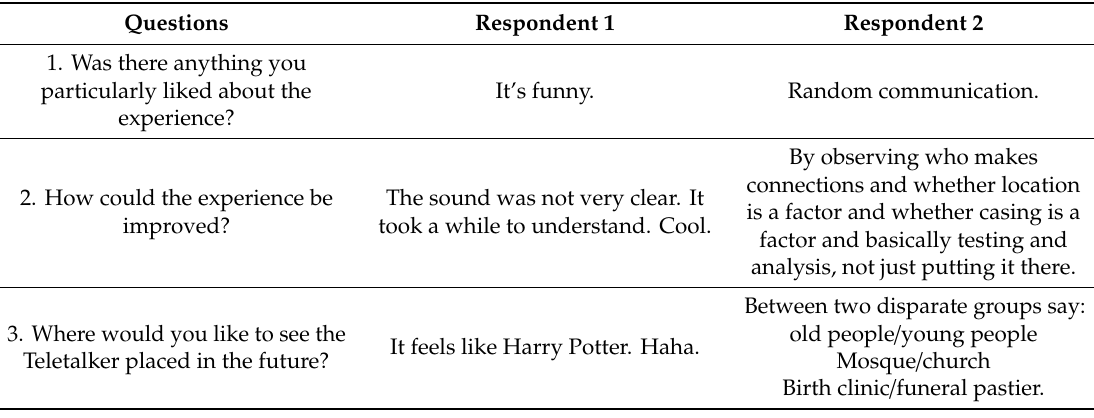
Table A3. Answers on questionnaire in the second in-the-wild intervention.